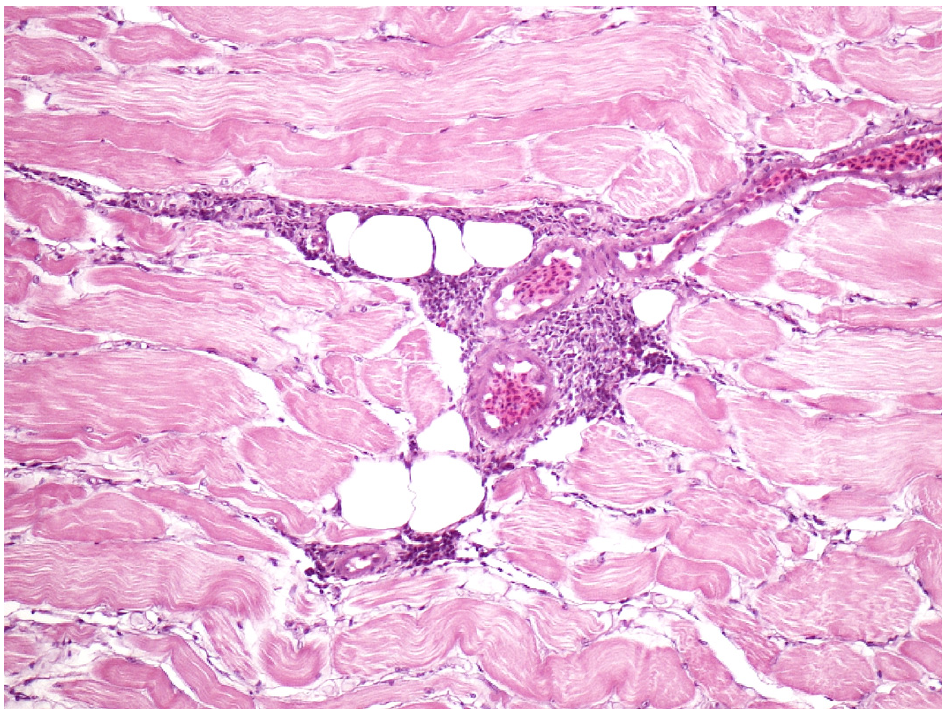
Figure 3. Skeletal muscle perivascular connective tissue moderately expanded by dense aggregates of mixed leukocytes; inflammation with no specific cause identified. Table 1. Abnormalities in sablefish tissues identified in histology slides. Each abnormality could possibly (P) have an effect on future health or it was unlikely (U).